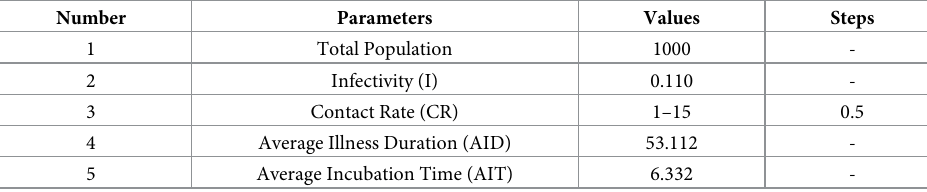
Table 5. Parameter values in the sensitivity analyses